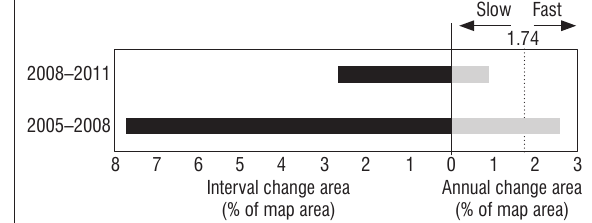
Figure 2: The landscape interval change occurring across KwaZulu- Natal between 2005–2008 and 2008–2011. The bars to the left (black) indicate the percentage area change occurring in the province in each interval, whilst the bars to the right (grey) represent the intensity of annual area of change within each time interval. Grey bars extending to the right or left of the vertical dashed line indicate a fast or slow change, respectively, relative to a uniform change across the analysis